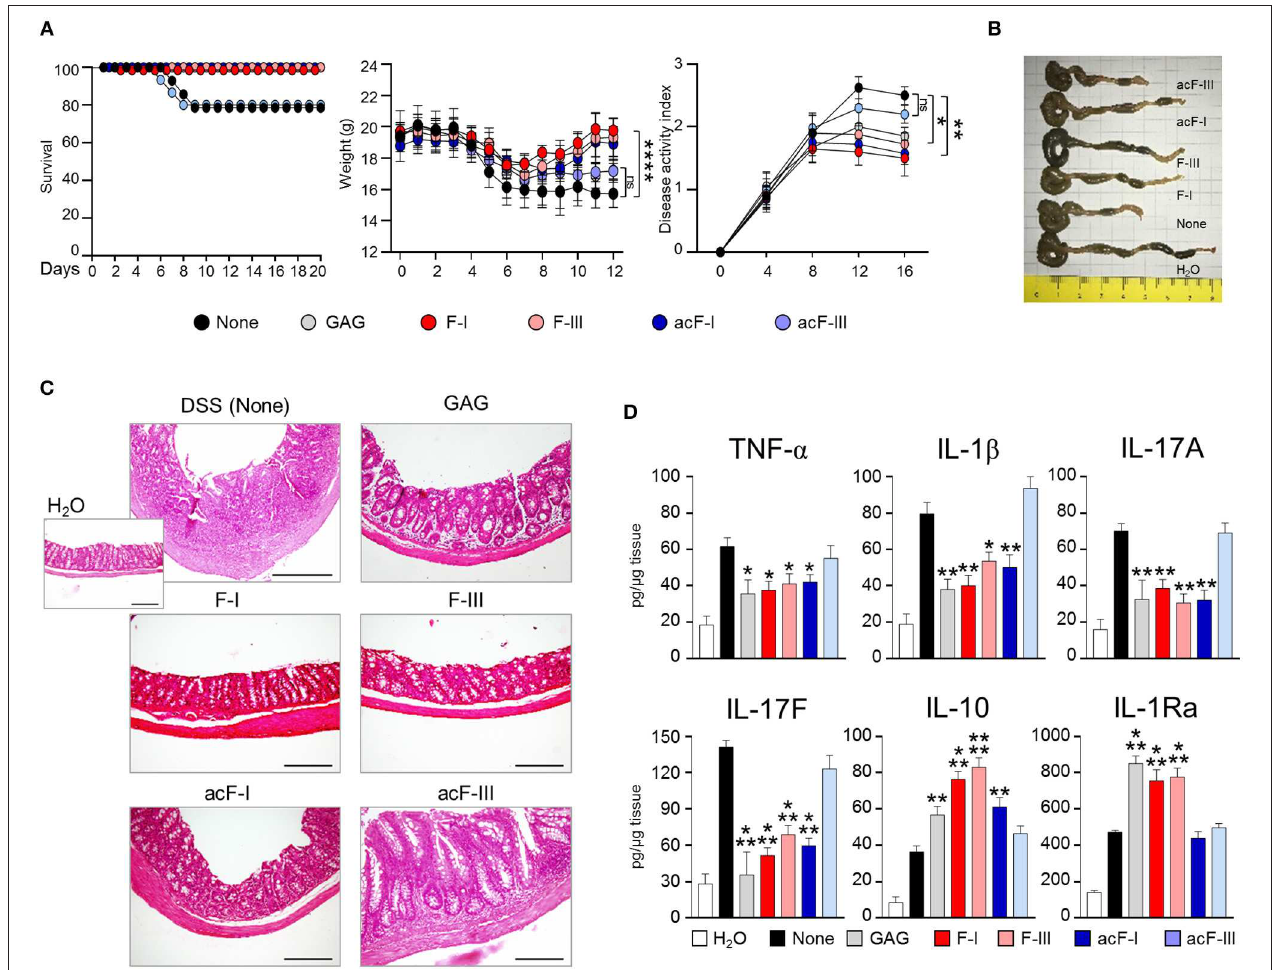
FIGURE 5 | Reduced severity of DSS colitis in C57BL/6 mice treated with modified GAG molecules. DSS or water vehicle was administered ad libitum in drinking water for 7 days. Native GAG polymer and GAG oligomers at the dose of 1 mg/kg were given intraperitoneally for 7 consecutive days after DSS treatment. (A) Survival, weight (grams) and clinical disease activity index. (B) Macroscopic image of colons. (C) Histological assessment of colitis severity (20X magnification, bar = 200 µ m). (D) Levels of colonic cytokines. Data are expressed as mean ± SD. * P < 0.05, ** P < 0.01, *** P < 0.001, **** p < 0.0001 GAGs-treated vs. untreated (None) C57BL/6 mice ( n = 10 mice/group from one experiment). ns, not